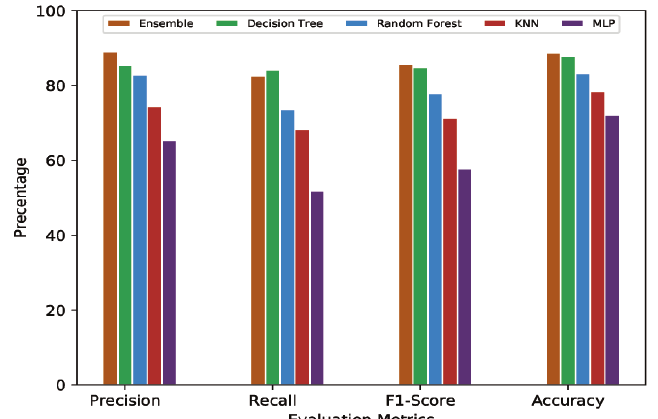
Figure 7. Graphical representation of comparative analysis of ML/DL approaches (prediction validity = 20 min, threshold =